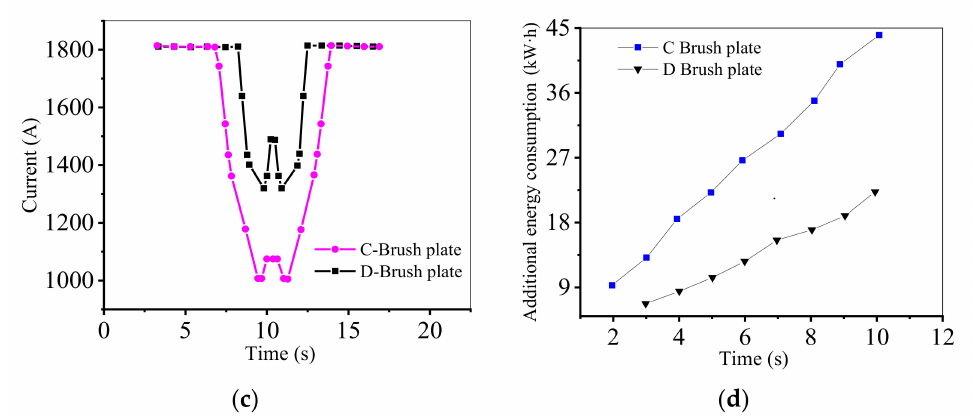
Figure 22. The variation of parameters with time. ( a ) The dimensionless current density; ( b ) Bath voltage; ( c ) Current, ( d ) Additional energy